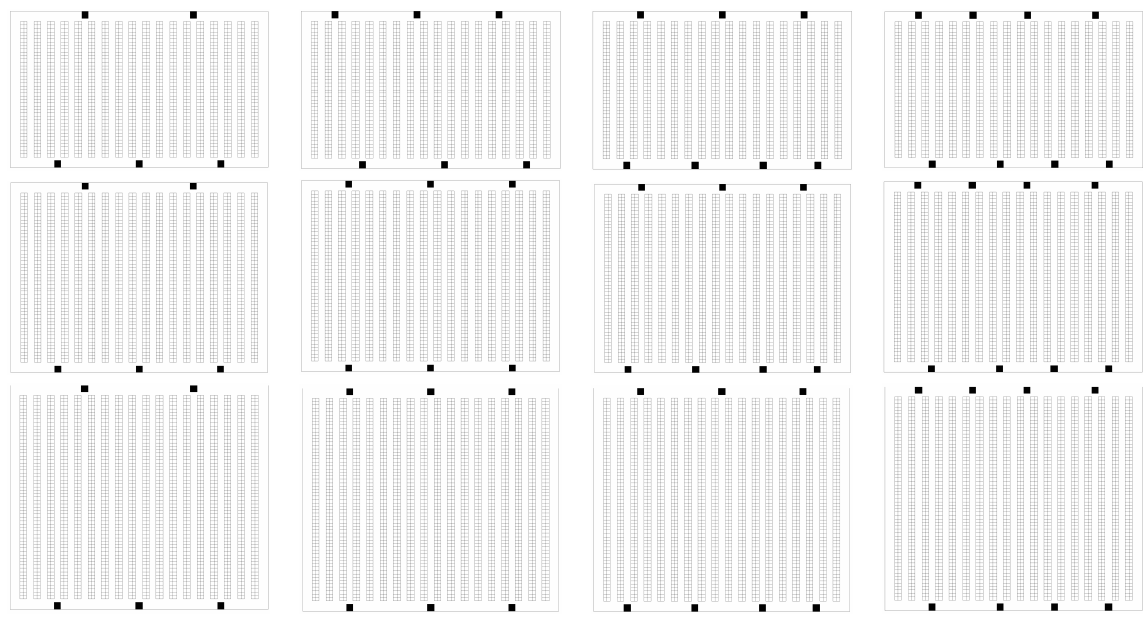
Figure A1. Optimal workstation layout in traditional warehouses ( N = 36; L = 40,50,60; K =